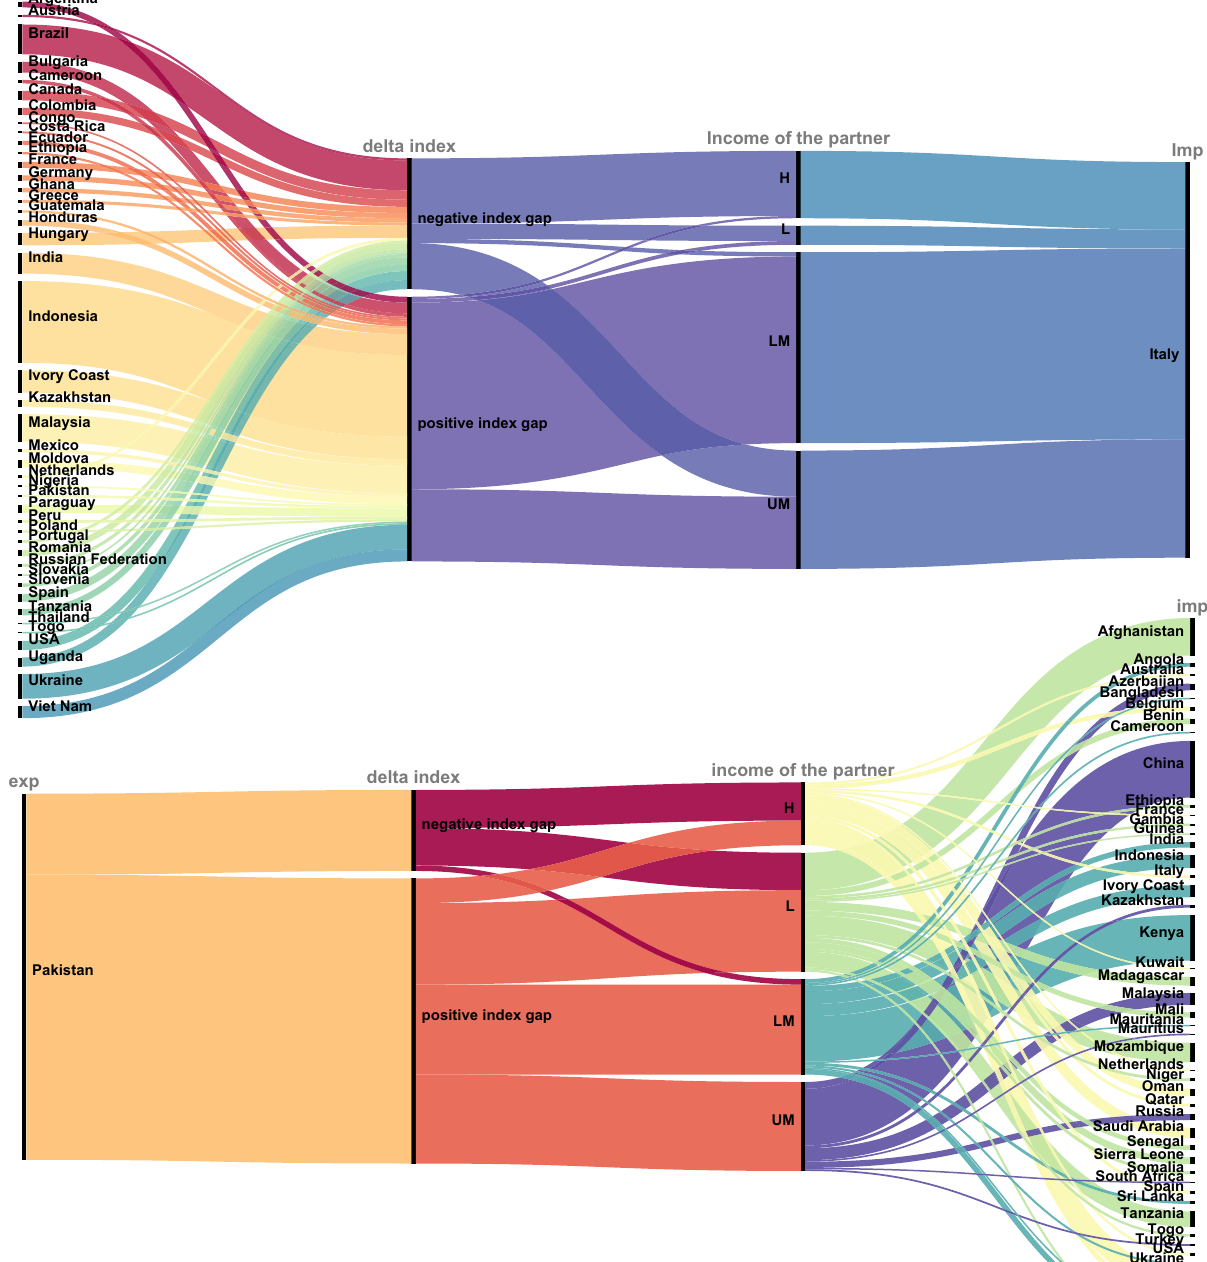
Figure 8. CWSI-weighted VW import for Italy (upper panel) and CWSI-weighted VW export for Pakistan (bottom panel). Left axis: Export. Right axis: Import. We included the fluxes representing 95% of the total traded volume (m3) by each of the two countries, both for export and for import. Positive index gap: exporter country has a higher composite water scarcity index than the importer (unfair exchange). Negative index gap: the exporter has a lower composite water scarcity index than the importer. H high income. UM upper middle income. LM lower middle income. L low